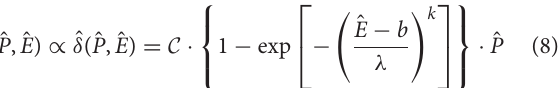
FIGURE 9 | FE results for f ( ˆ E ) (black circles) and their exponential fitting (red dashed-line); fitting parameters are k f 1 that correlated with the guard cell elongation mode was obtained for ˆ E ≈ (cid:16) (cid:17) ˆ E ≥ 10 (blue lines). The threshold ˆ E deformation was in elongation mode, is indicated by the blue line; a representative displacement map of stomatal opening in elongation mode (for * ) is ˆ E = 40 > ˆ E